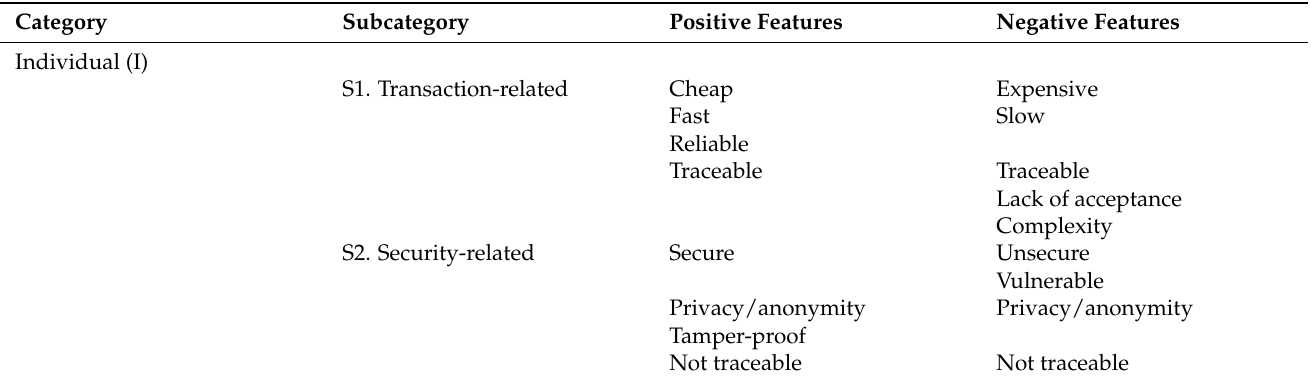
Table 2. Influencing factors (properties) on different levels.